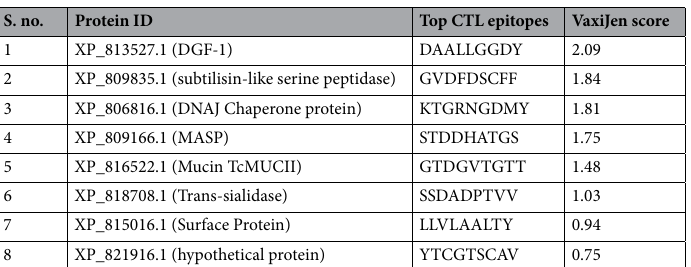
Table 5. Predicted linear cytotoxic T-lymphocyte epitopes in the selected proteins for designing vaccine constructs.